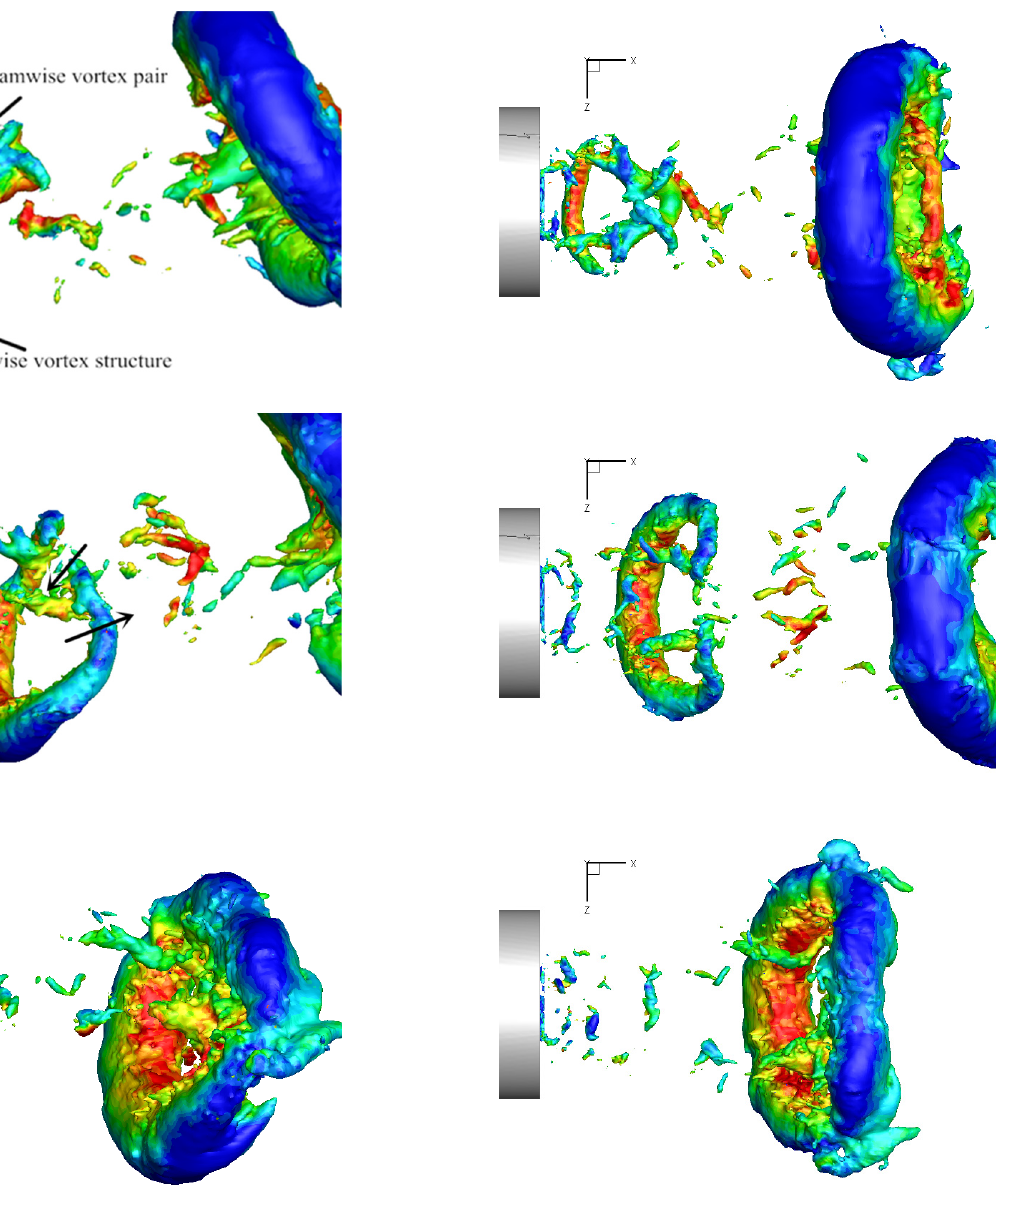
Figure 20. Interaction between the streamwise vortex pair and azimuthal vortex, visualized by the iso-surface of pressure and colored by the streamwise velocity magnitude, p / ρ U j 2 = − 0.15.